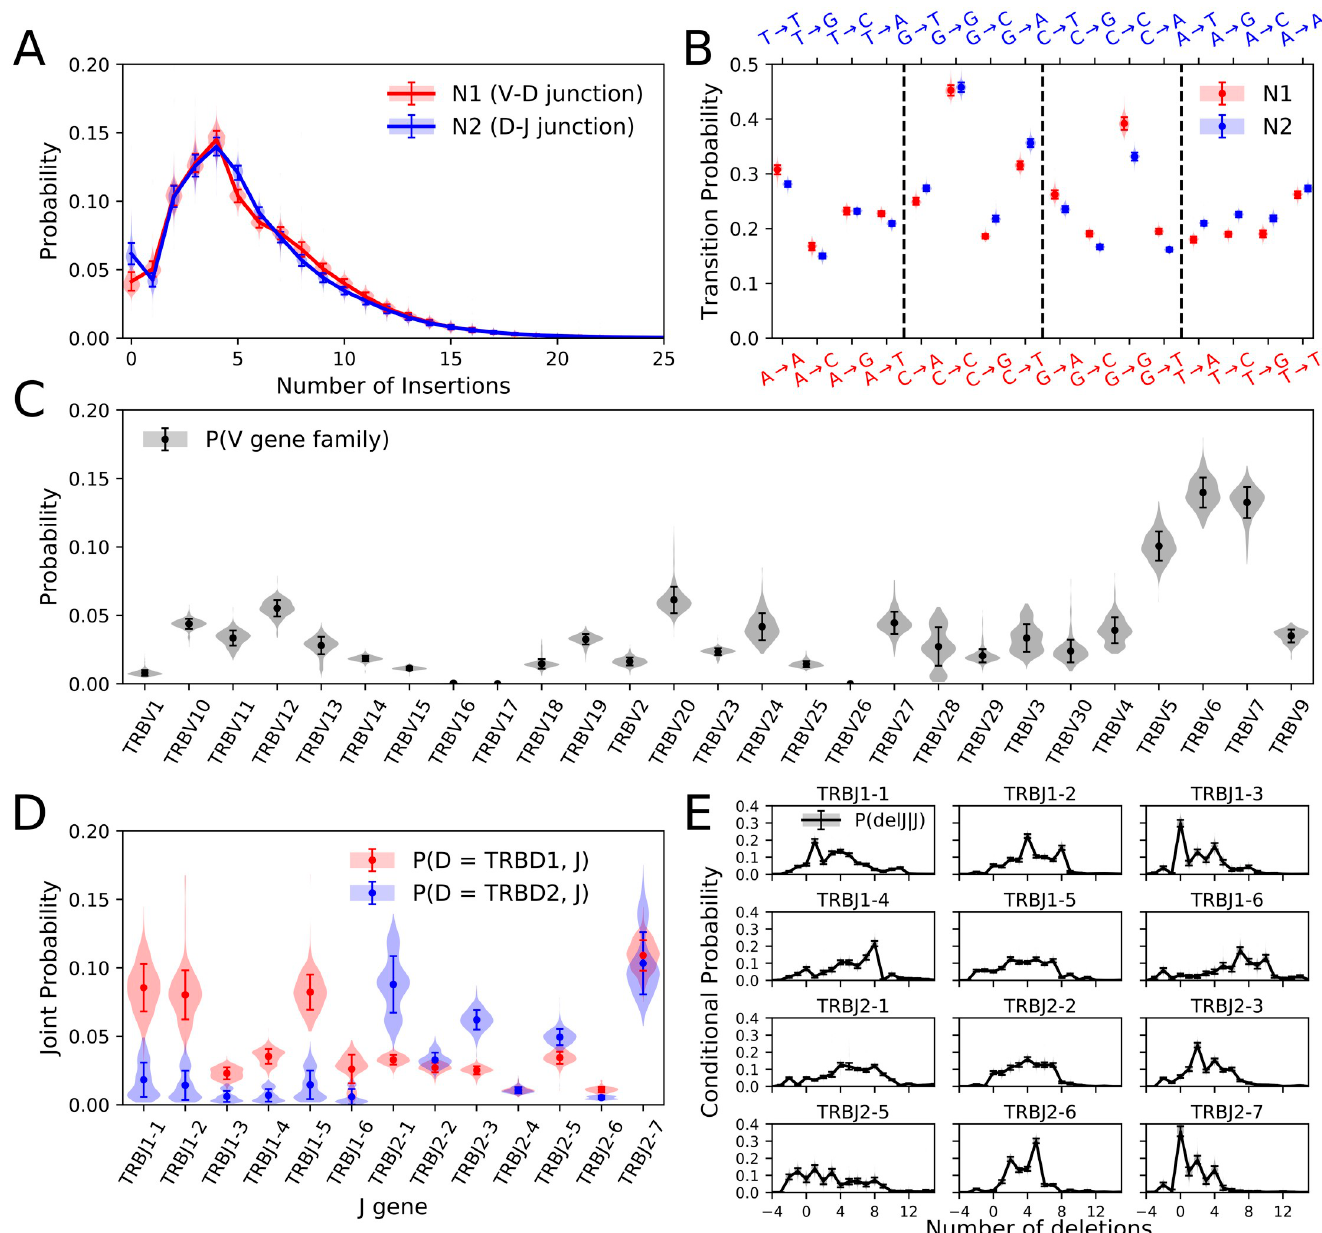
Fig 2. Distribution of the individual P i model parameters over 651 individuals. All plots are violin plots with the mean and standard deviation shown by error gen bars. (A) Insertion length distributions of the N1 and N2 junctions. (B) Markov transition probabilities for the inserted nucleotide identities at the N1 (red) and N2 (blue) junctions. The N2 transition probabilities are organized in a reverse complementary fashion to the N1 transition probabilities. (C) V gene family usages. (D) Joint D and J gene usages. (E) Deletion profiles for individual J genes. (deletion profiles for the V genes are shown in S1 Fig).